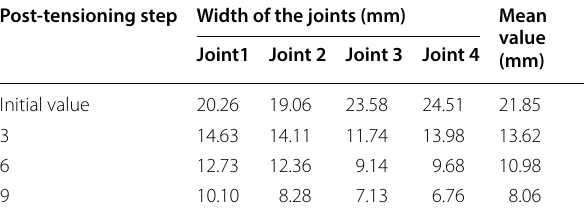
Table 3 Experimental data of width of the joint. Post‑tensioning step Width of the joints